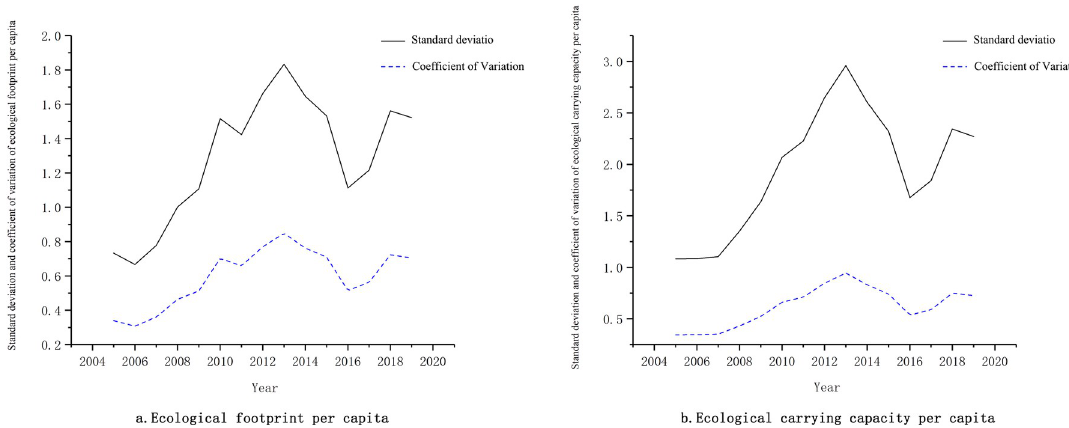
Fig 5. Ecological footprint per capita, standard deviation of ecological carrying capacity per capita and coefficient of variation in Shenyang. a. Ecological footprint per capita. b. Ecological carrying capacity per capita.